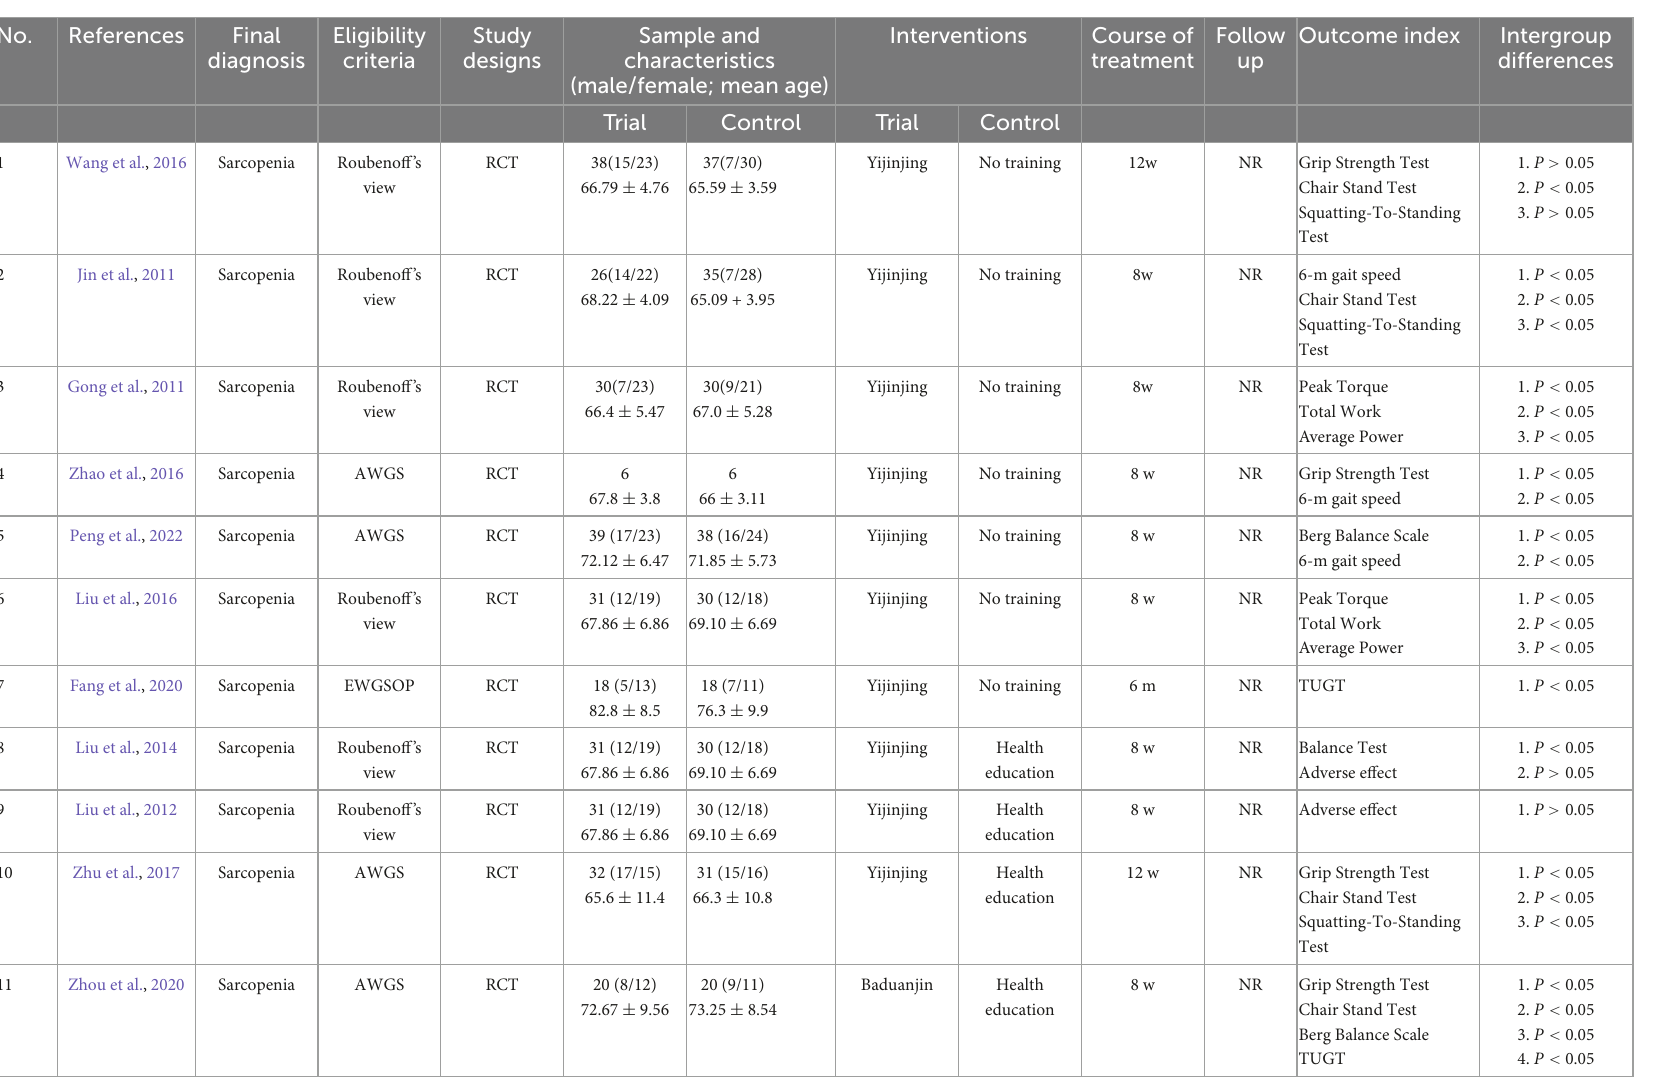
TABLE 1 Characteristics of included